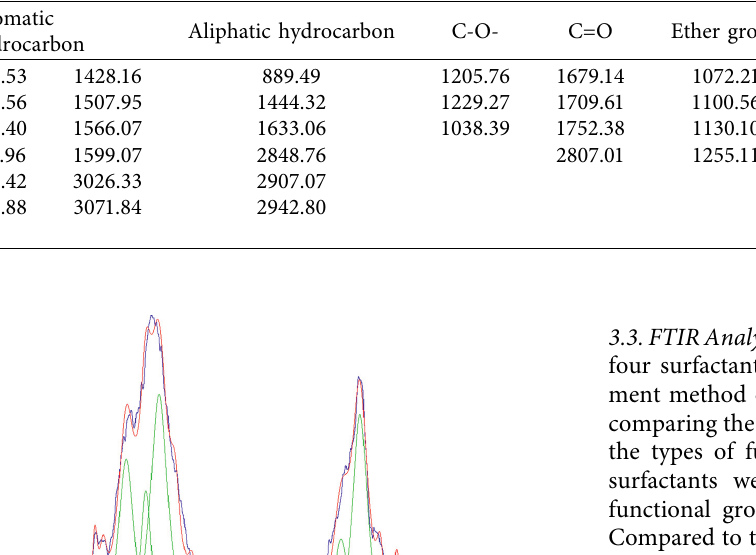
Figure 5: FTIR of bituminous coal dust. (a) 715cm − 1 –920 cm − 1 ; (b) 920cm − 1 –1400cm − 1 ; (c) 1400cm − 1 –1720 cm − 1 ; (d) 2775cm − 1 –3115cm − 1 ; (e) 3117cm − 1 –3700cm − 1 . Table 2: FTIR peak assignment and position of bituminous coal dust (cm − 1 ).